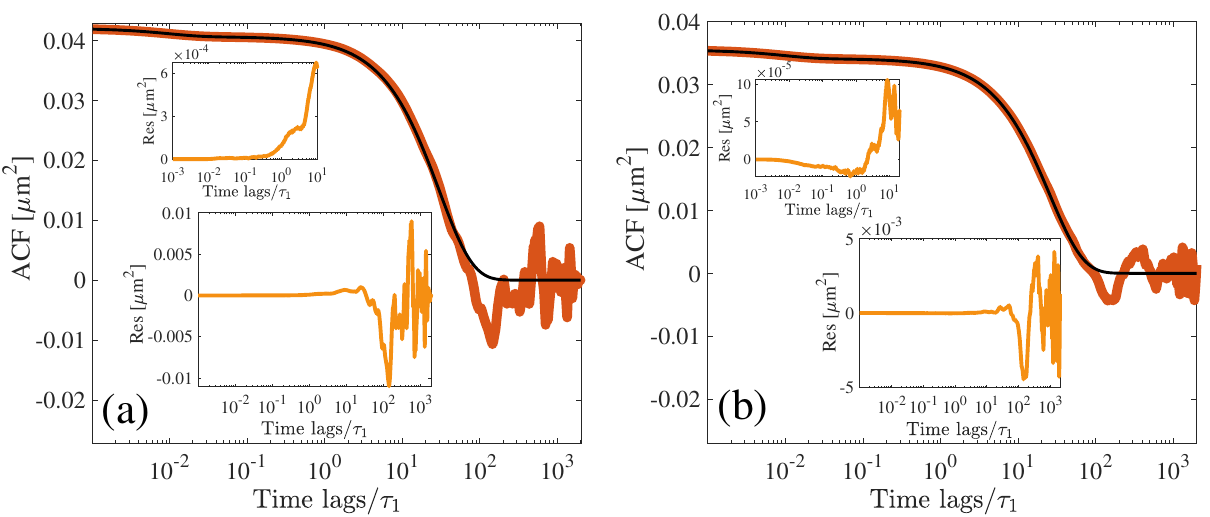
0.1 and ( a ) T s /τ 1 2000 , ( b ) T s /τ 1 10000 = = =